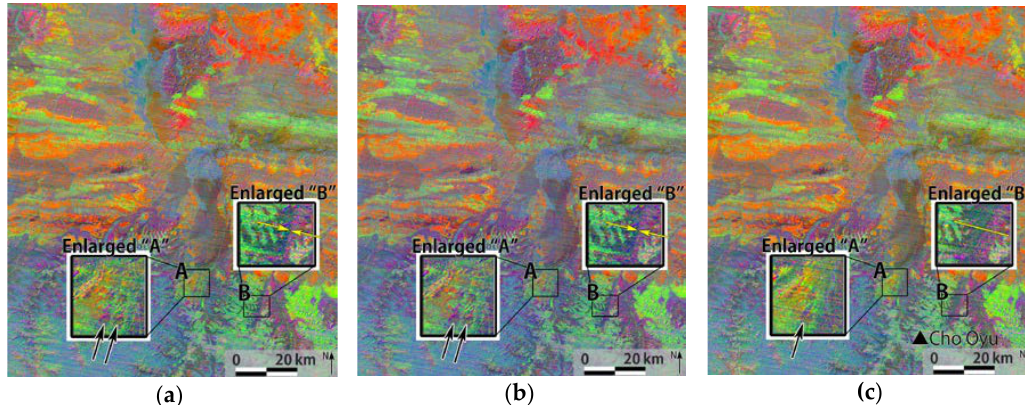
Figure 7. Mosaic color composite image of QI, CI and MI covering the region bounded by the latitude 28° N to 29° N and the longitude 86° E to 87° E with ( a ) ASTER Level-1B products; ( b ) ASTER Level-2B04 products and ( c ) ASTER LEVEL-3A products. The coverage in the study area is indicated as a yellow rectangle in Figure 2. A linear contrast stretching of 0.97–1.055 (QI; Red), 1.005–1.055 (CI; Green) and 0.79–0.95 (MI; Blue) is applied on (a, c ), and 0.975–1.085 (QI; Red), 1.09–1.145 (CI; Green) and 0.76–0.96 (MI; Blue) is applied on (b). The sub-areas “A” and “B” are enlarged for pointing out the parallax effects. For “A”, the rock unit shown in ( c ) indicated with an arrow is observed as double in (a,b) as indicated with two arrows. For “B”, the lithological boundary shown across the yellow line in ( c ) is overlapped and a part of the area is missed along the boundary in (a,b) as indicated with the yellow arrows on the line. These suggest the geometrical mis-registration by the parallax effect occurred for Level-1B and Level-2B products, which are corrected for the Level-3A product. The location of Mt. Cho Oyu is indicated in ( c ).